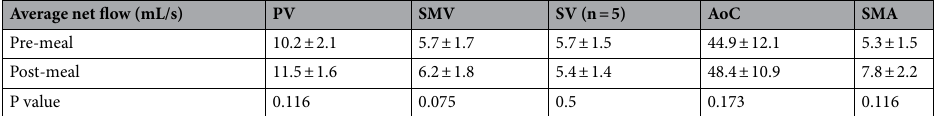
Table 2. Average flow results in patient cohort. PV portal vein, SV splenic vein , SMV superior mesenteric vein, AoC aorta at coeliac artery, SMA superior mesenteric artery.